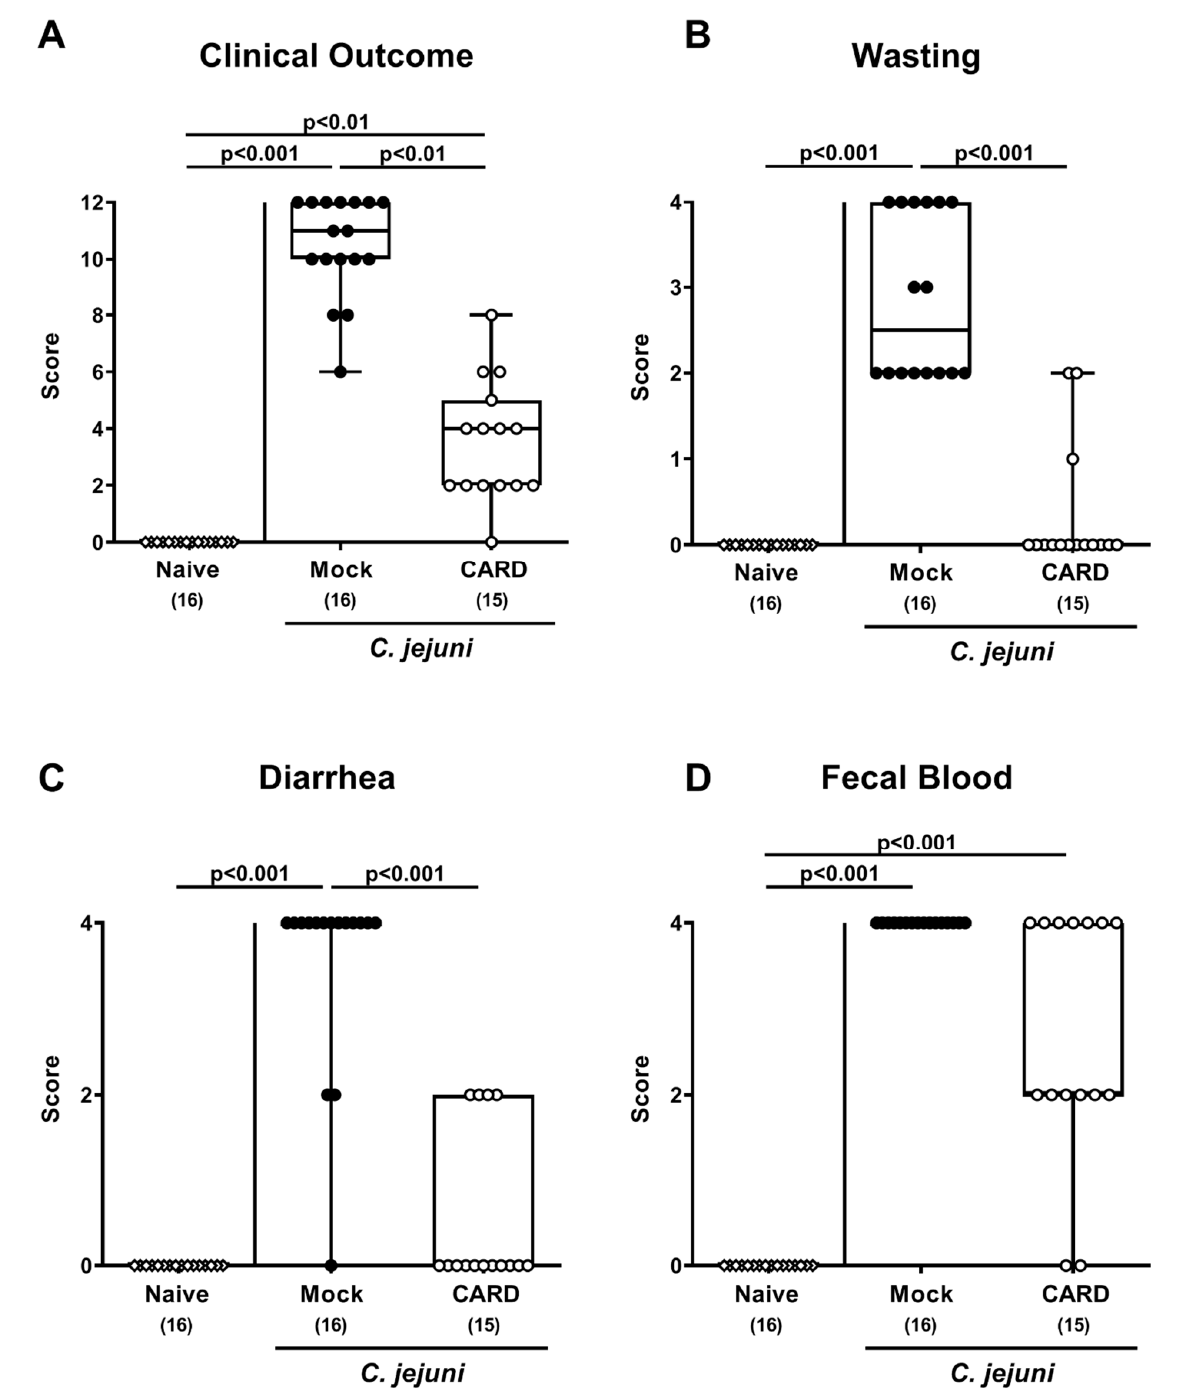
Figure 2. Clinical outcome following oral cardamom essential oil application to C. jejuni -infected microbiota-depleted IL-10 − / − mice. Microbiota-depleted IL-10 − / − mice were infected with C. jejuni strain 81–176 on days 0 and 1 by gavage and perorally challenged with cardamom essential oil (CARD; white circles) via the drinking water starting on day 2 post-infection, whereas mock control mice received vehicle (black circles). On day 6 post-infection the ( A ) clinical outcome as determined by ( B ) wasting, ( C ) diarrhea, and ( D ) fecal blood were quantitatively assessed by a clinical scoring system. Naive mice (open diamonds) served as untreated and uninfected controls. The box plots indicating the 75th and the 25th percentiles of the median (black bar within box), the total range, the levels of significance ( p values), as calculated with the Kruskal–Wallis test, and Dunn’s post-correction and the number of analyzed mice (in parentheses) are shown. Data were pooled from four independent experiments.